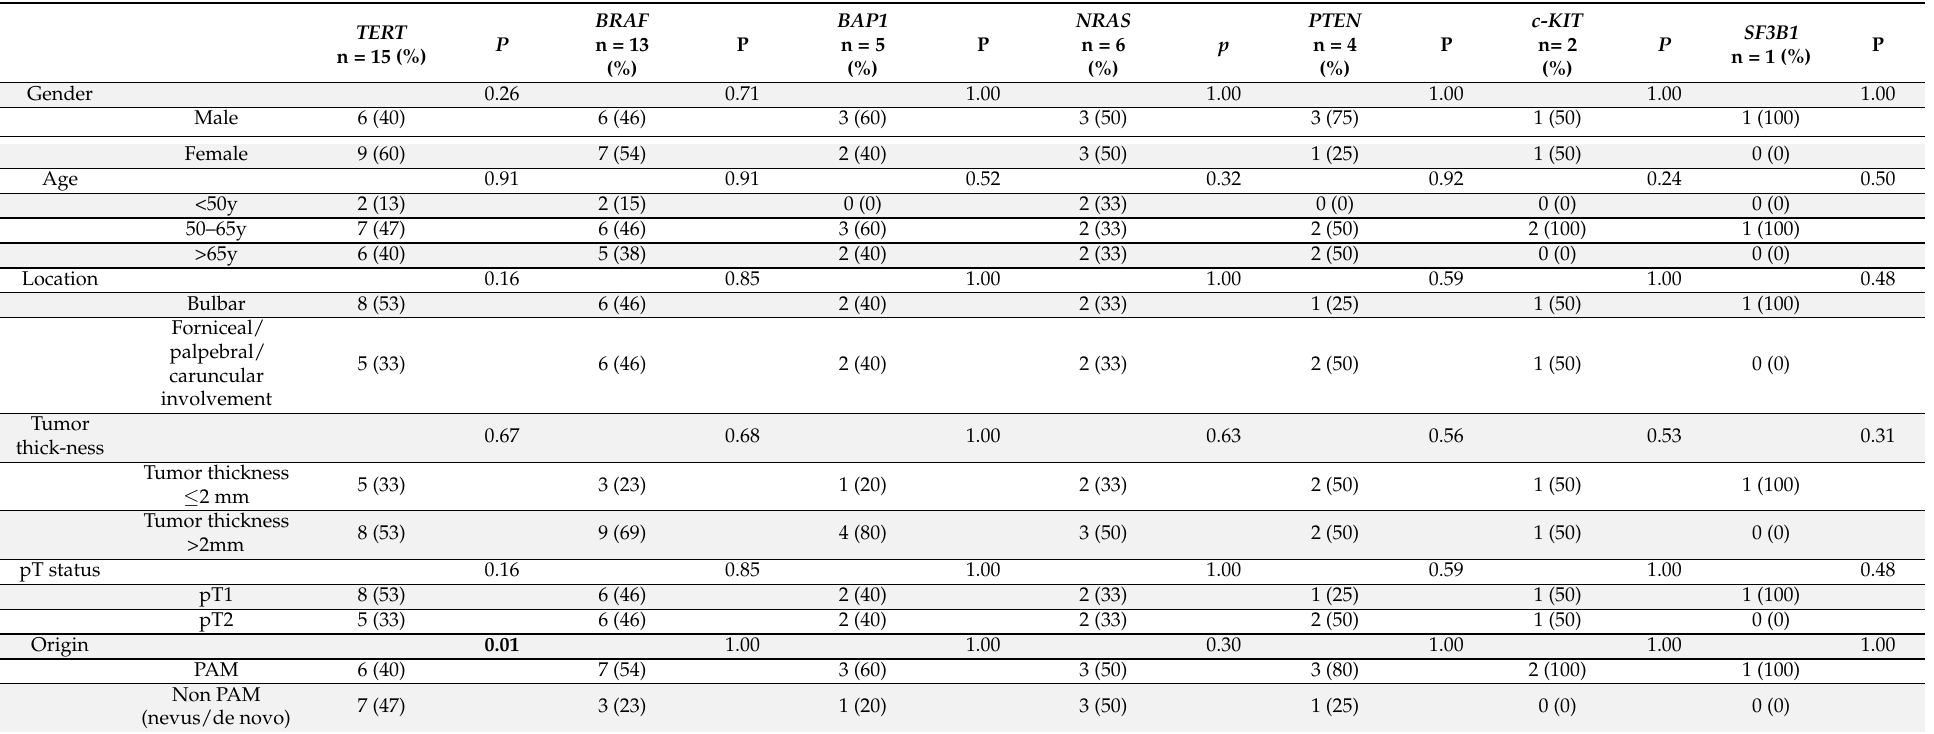
Table 3. Mutations versus clinical and histopathological